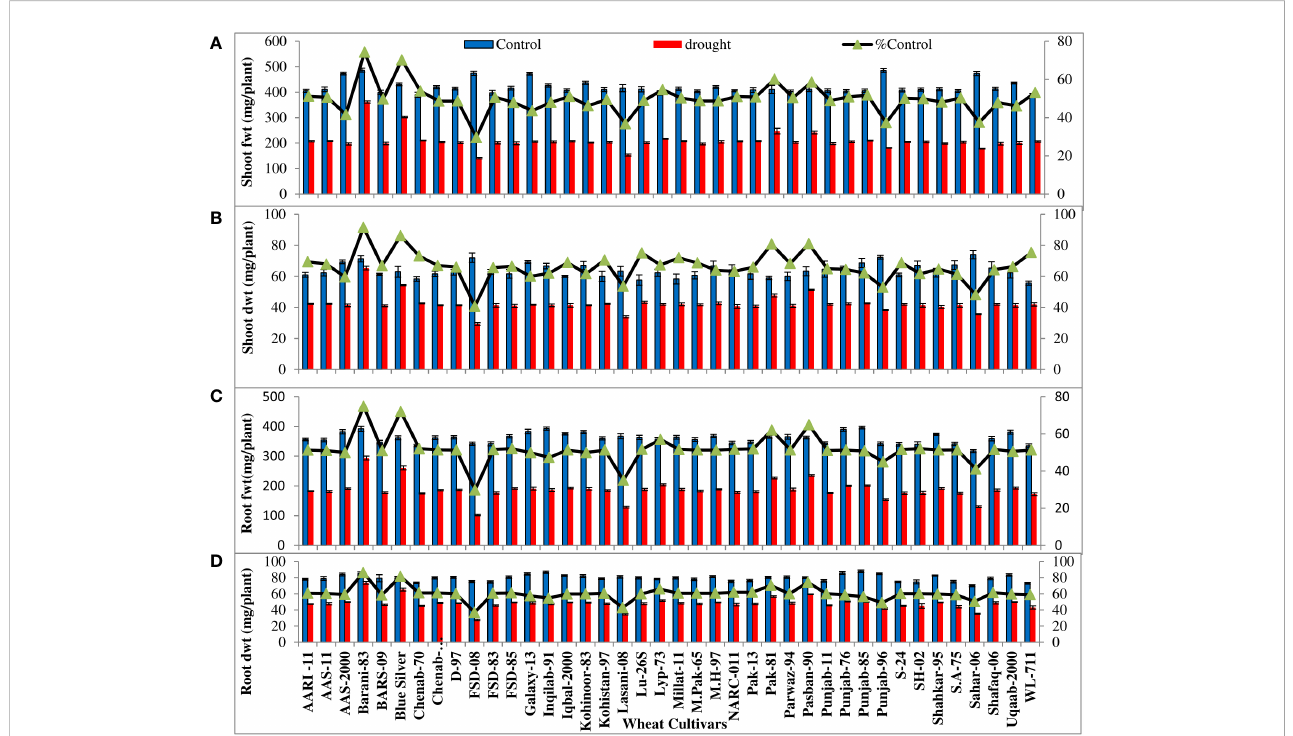
FIGURE 1 Shoot and root fresh and dry weights (mg/plant) of wheat seedlings, when plants of 40 local wheat cultivars were grown under normal or PEG-induced drought stress for 2 weeks. Means (± SE; n=5) are presented on the primary vertical axis, while % of the control values are presented on the secondary